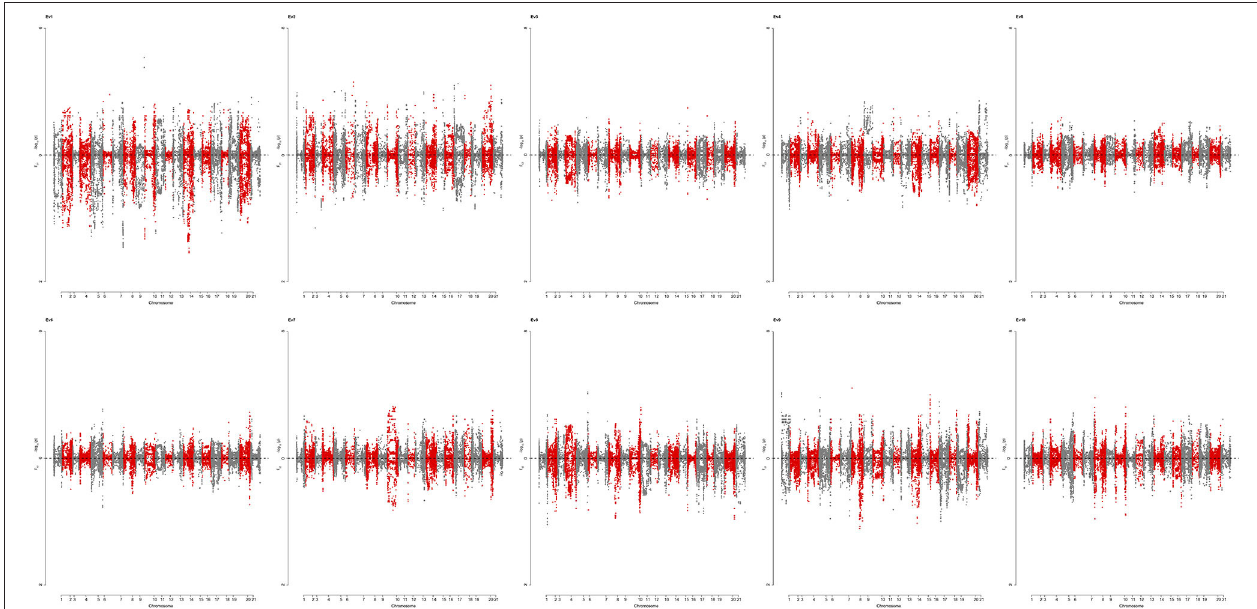
FIGURE 5 | Miami plot showing loci under selection identified by EigenGWAS (upper for PGC and lower for F ST ) for top 10 eigenvectors (EV) based on 422 wheat accessions. PGC is the p corrected by lamdaGC in EigenGWAS. EV1-EV10 were the first 10 eigenvectors, each of which was used as phenotype for EigenGWAS